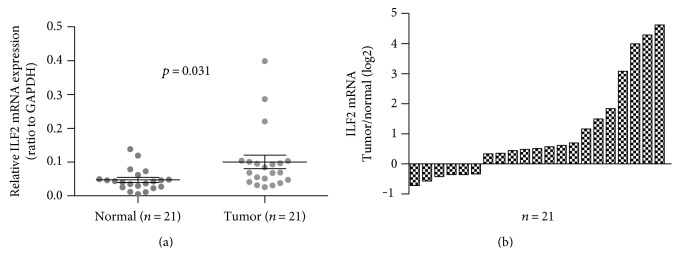
The expression levels of ILF2 mRNA in 21 paired samples by qRT-PCR. Scatter plots of the relative expression of ILF2 between GC tissues (tumor) and normal controls (normal) to GAPDH, GAPDH as an endogenous control (p = 0.031, paired t-test, two-tailed) (a). Bar plots of the relative expression of ILF2 in GC tissues compared with adjacent normal tissues; each patient was presented as the log2 ratio of tumor tissues/normal tissues (b).